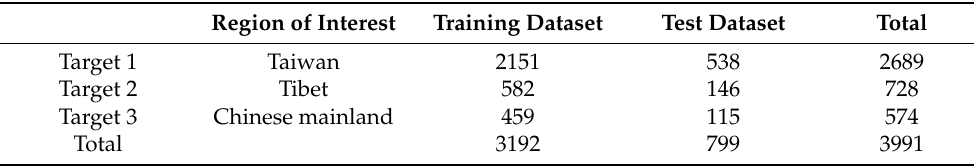
Table 1. Sample distribution of different